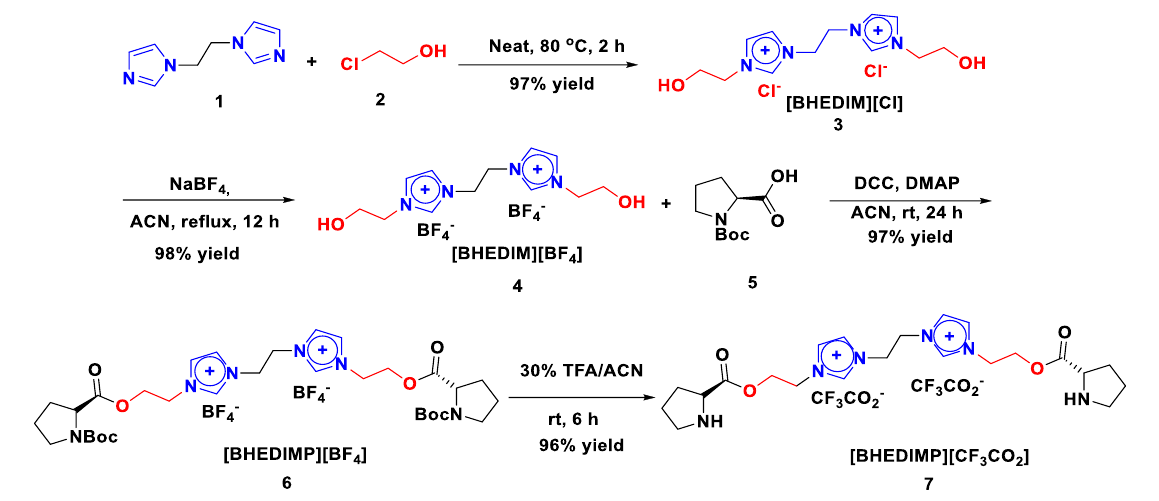
Table 1. Solvent screening for the synthesis of 11b a